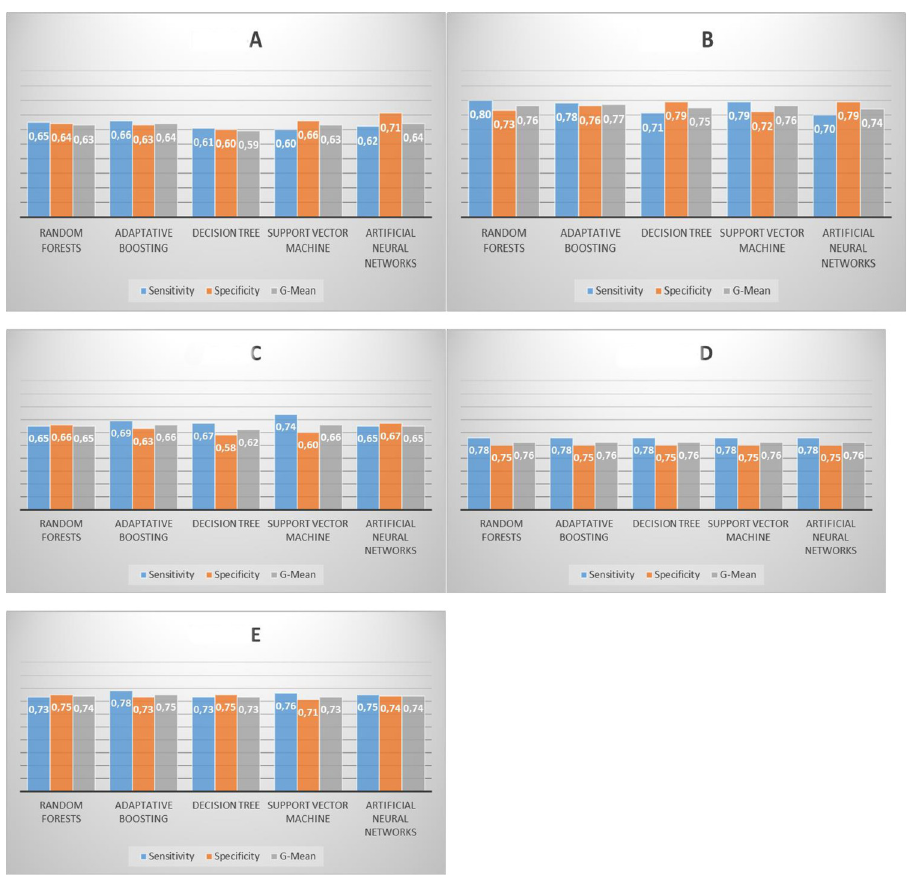
Fig 3. Performance of models in predicting death for patients with CD, within two years, according to each machine learning technique adopted. Fig 3A: Considering the interview variables. Fig 3B: Considering the variables of complementary exams. Fig 3C: Considering the variables of complementary exams, excluding the categorized NT- proBNP variable. Fig 3D: Considering the variables of complementary exams, considering only the NT-proBNP variable. Fig 3E: Considering the interview variables and complementary exam